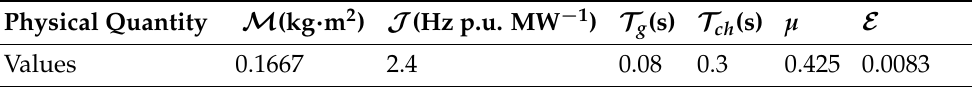
Table 2. System parameters utilized in simulintion section.